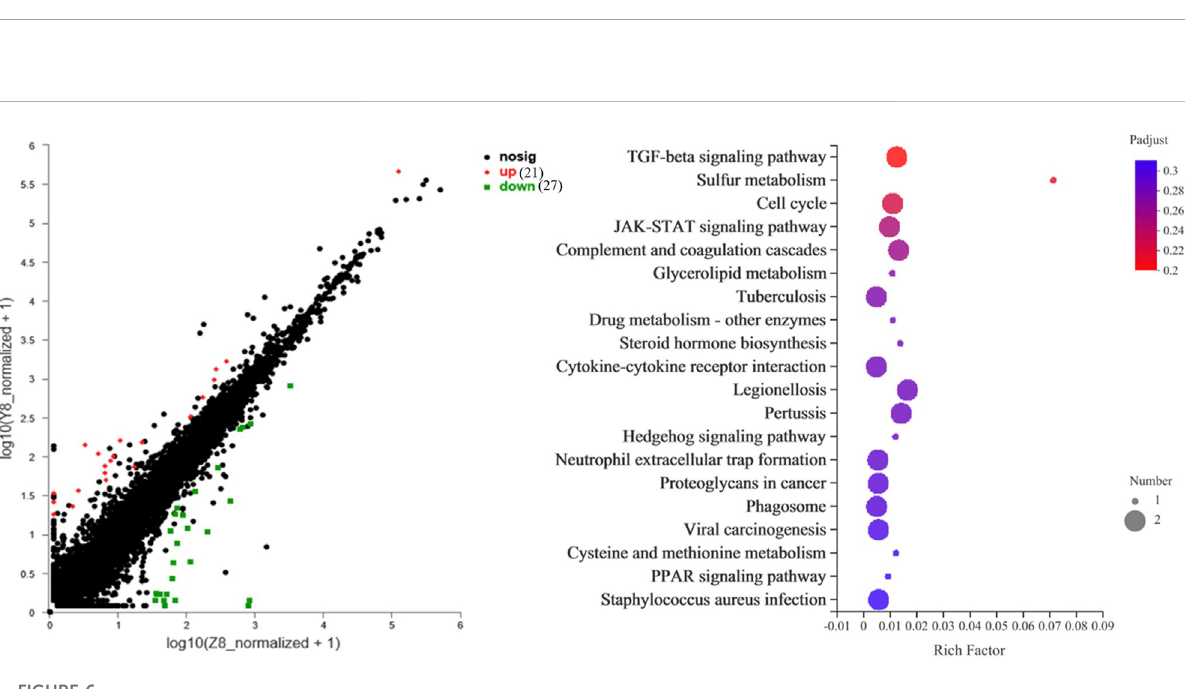
FIGURE 6 The top 20 KEGG pathway of the differential genes between W12 (control) and Y12 groups. The rich factor represents the enrichment degree, and the dot size represents the number of genes in the corresponding